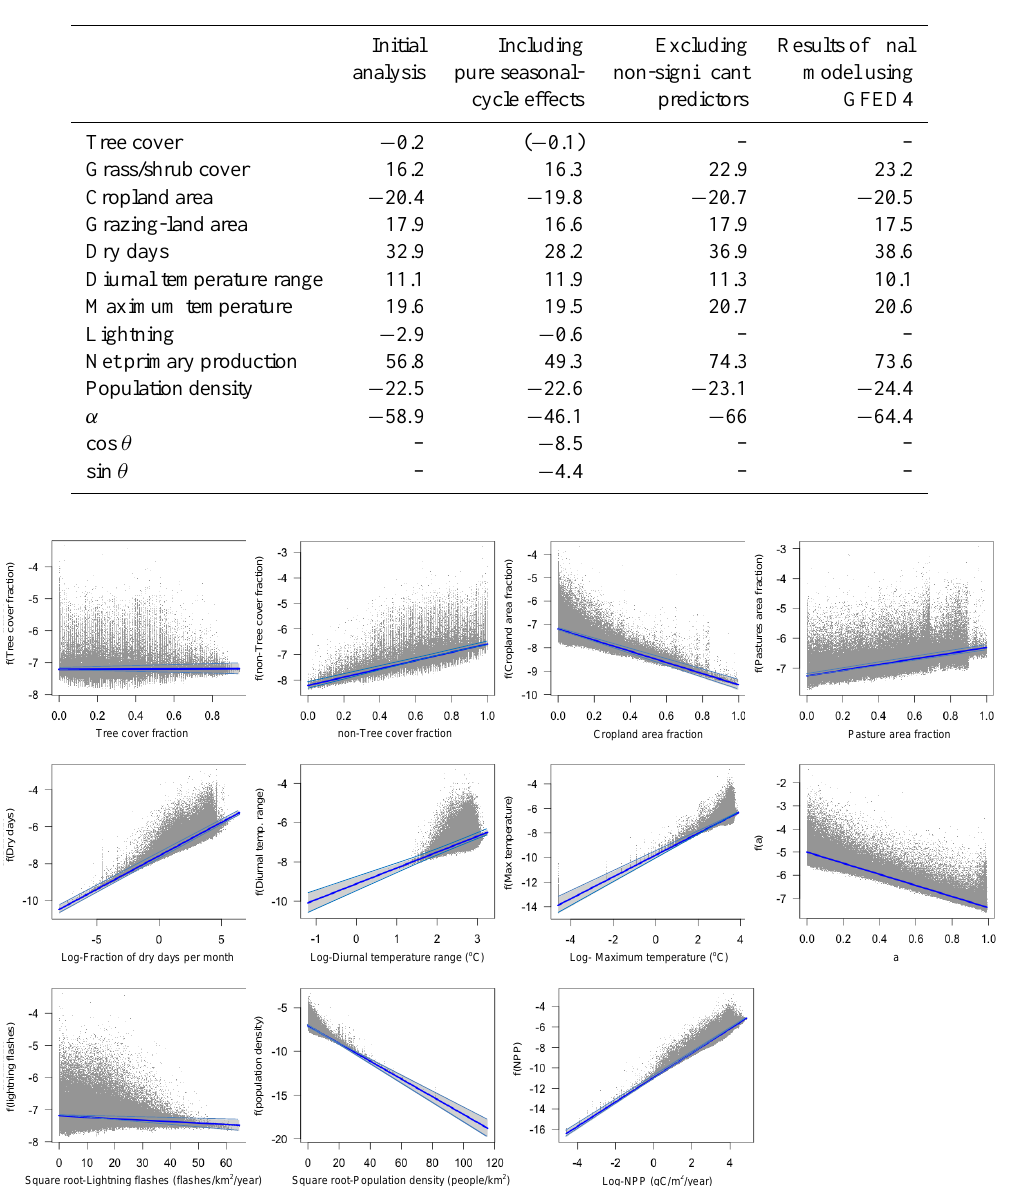
Table 2. Regression coefficients from each of the three models. Non-significant values ( P >0.05) in parentheses.